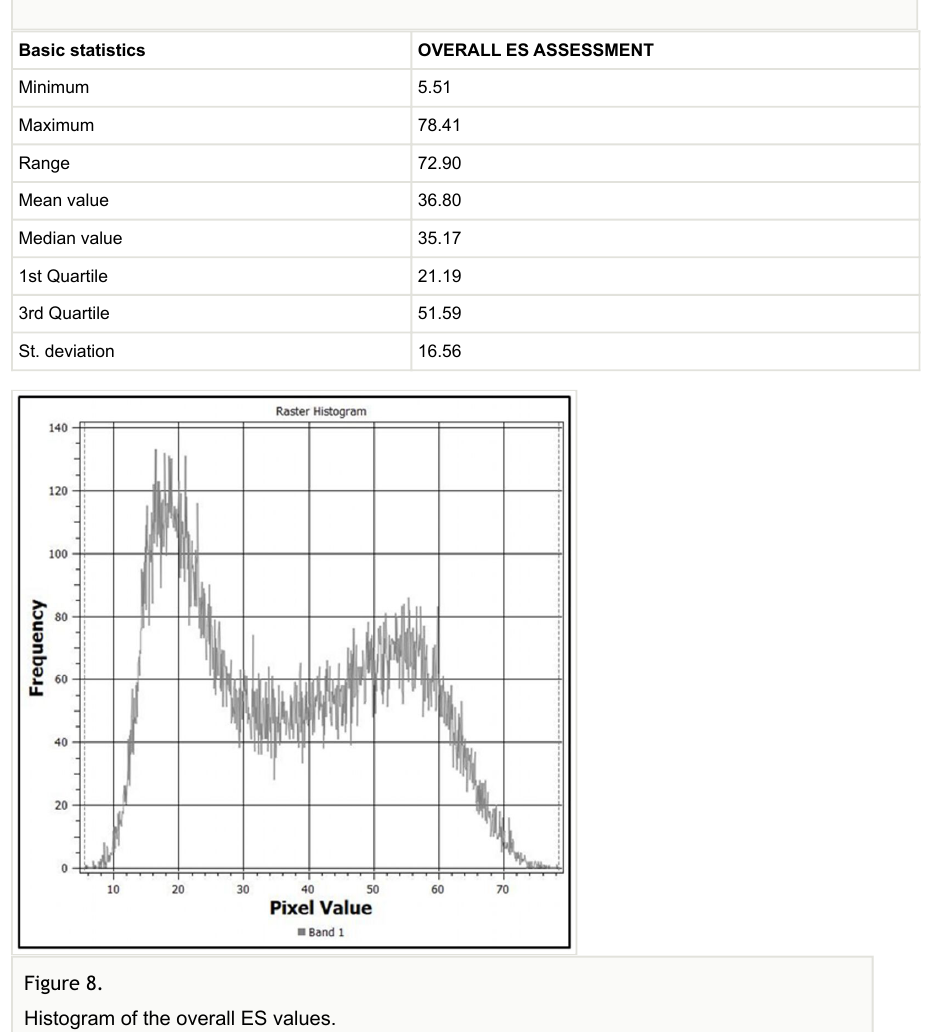
Basic statistical parameters of the analysed ES groups*4.